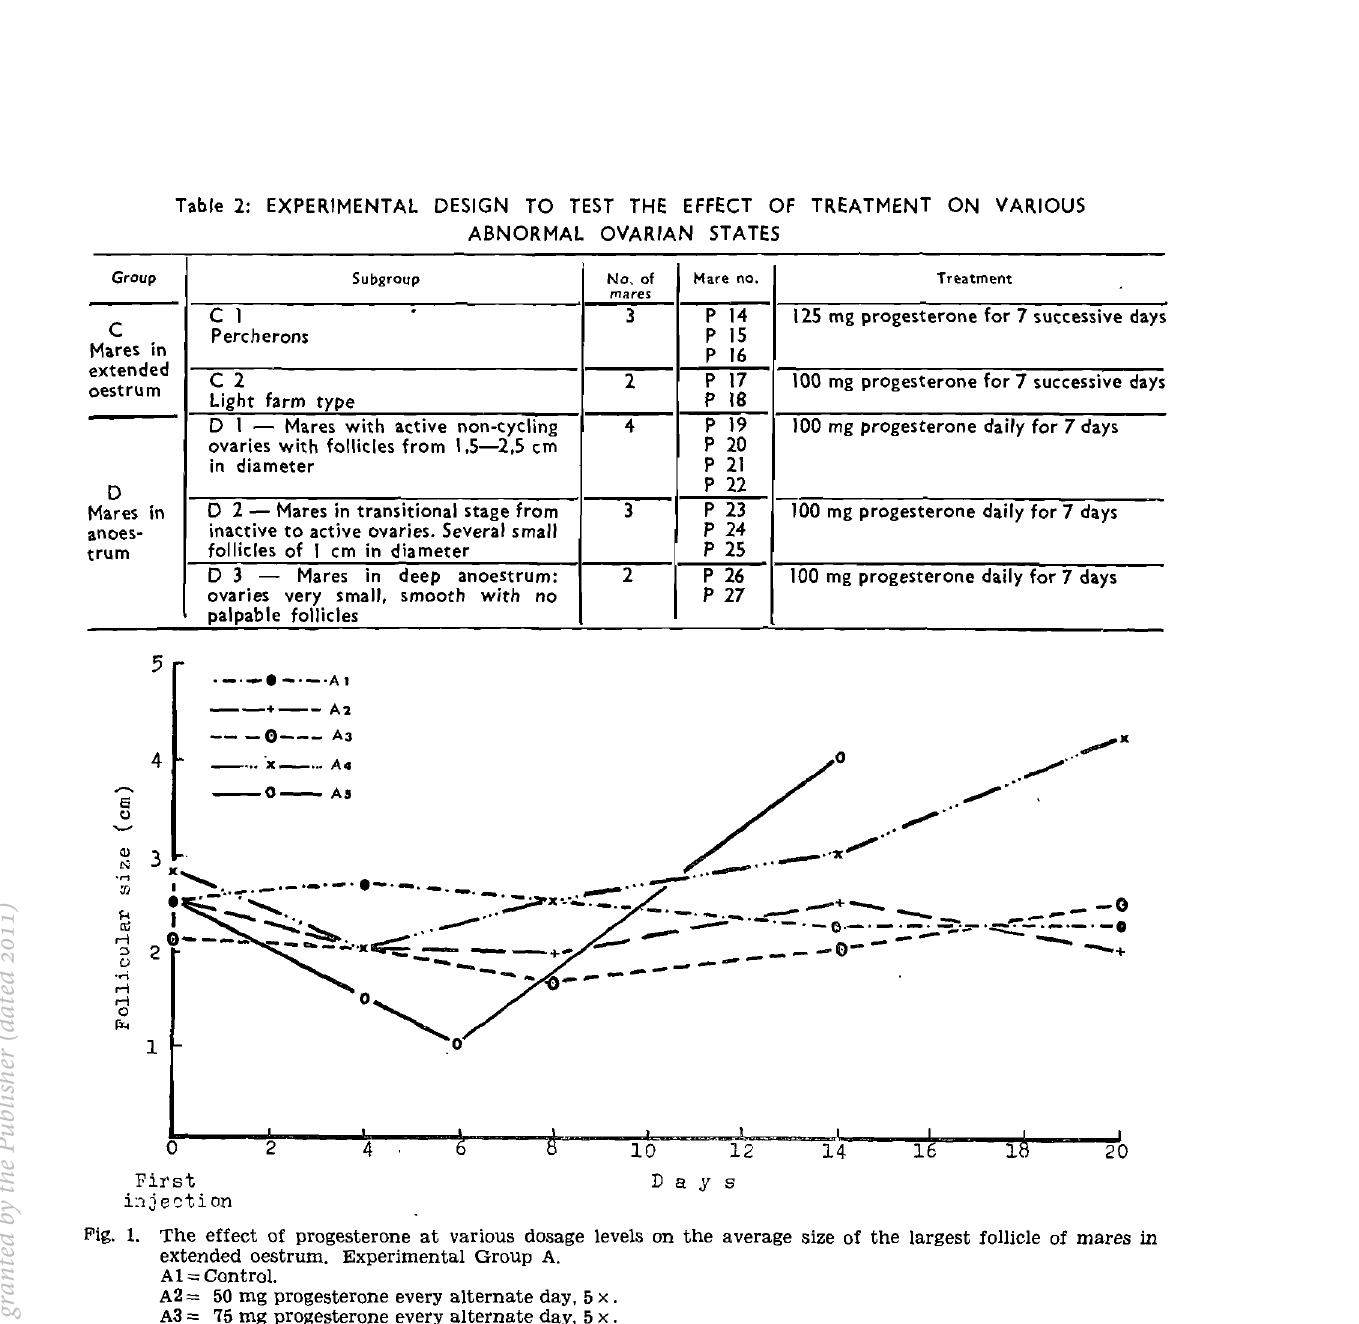
Table 2: EXPERIMENTAL DESIGN TO TEST THE EFFECT OF TREATMENT ON VARIOUS ABNORMAL OVARIAN STATES Group Subgroup No. of Mare no. Treatment mares